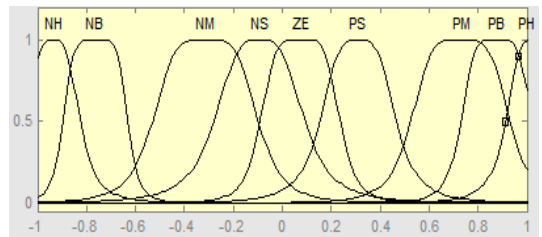
Figure 14. Membership functions of Pr(t-T) after training